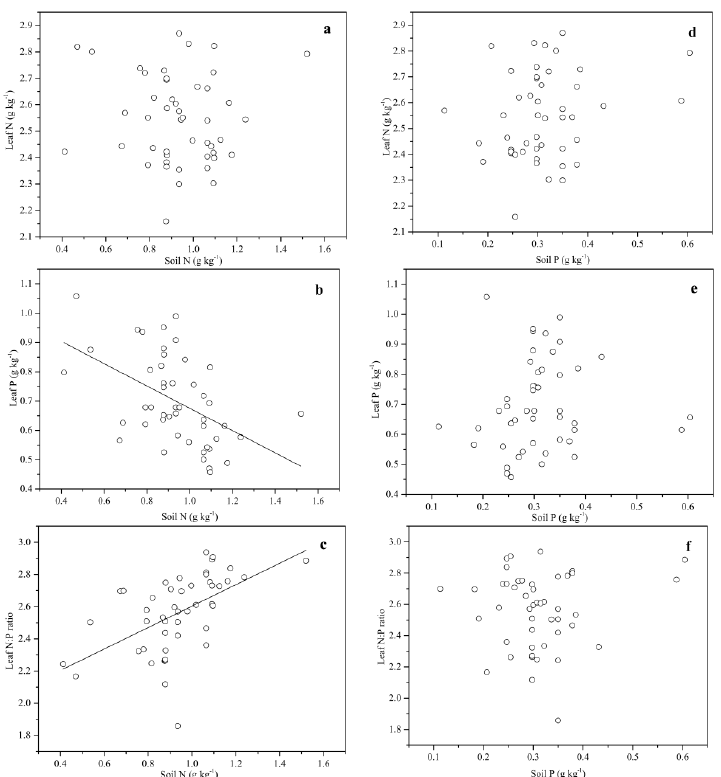
Figure 5. Relationships between the leaf stoichiometry and soil nutrients variables for Chinese fir. Each data point represents an ln (N + 1)-transformed leaf and soil N, leaf and soil P concentration, or leaf N:P ratio. Linear fit for ( b ) the leaf P and soil N ( R 2 = 0.23, p < 0.001); and linear fit for ( c ) the leaf N:P ratio and soil N ( R 2 = 0.28, p < 0.001). No fit for ( a ) the leaf N and Soil N; ( d ) the leaf N and Soil P; ( e ) the leaf P and Soil P; and ( f ) the leaf N:P ratio and Soil P.